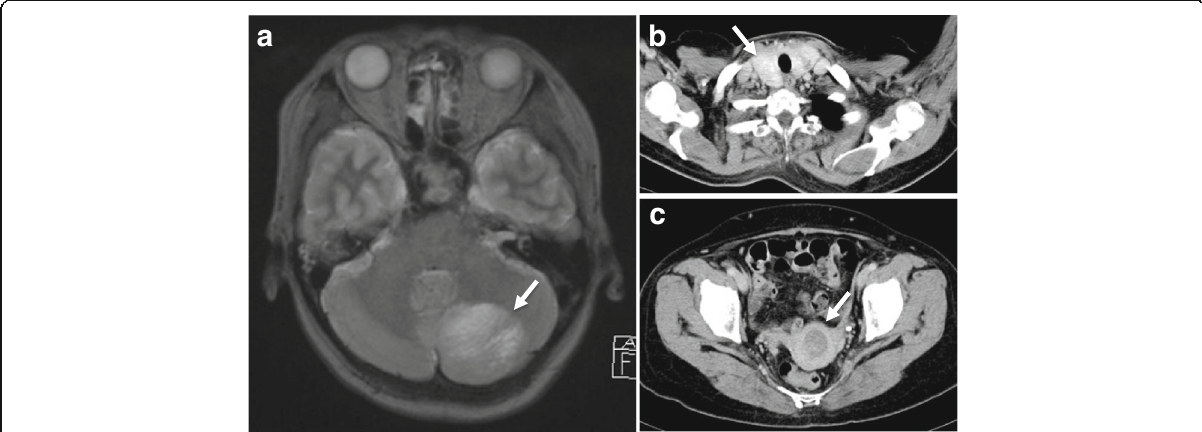
Fig. 1 MRI and CT at the age of 50 years. a MRI showed alternating isointense and hyperintense bands in the left cerebellar hemisphere ( arrow ).